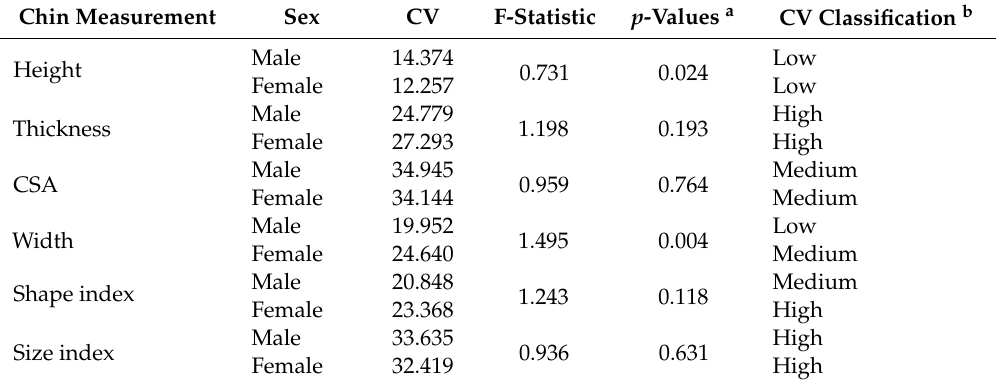
Table 5. Variation in chin morphometrics in males and females (males n = 203; females n =